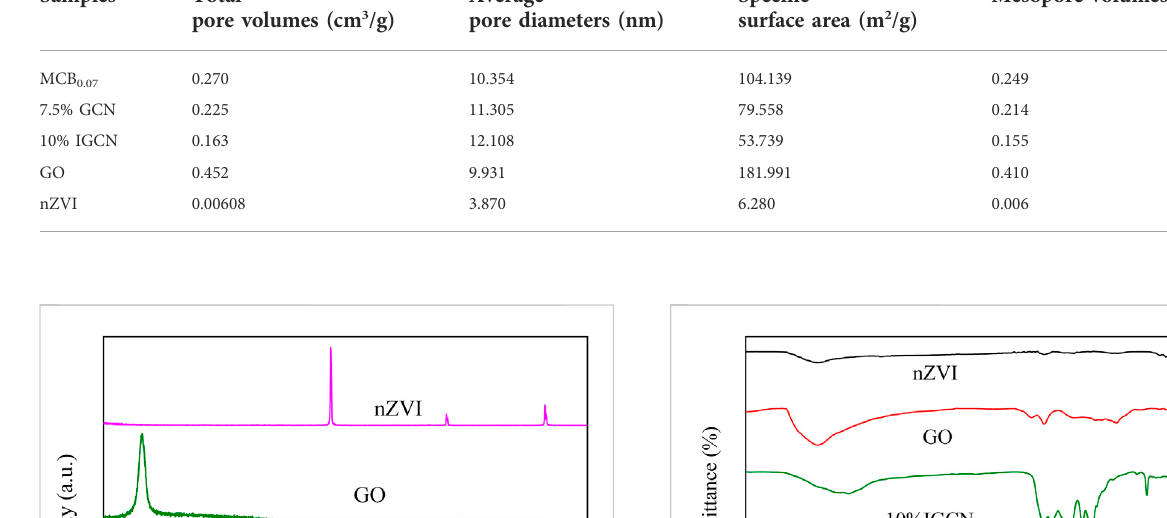
TABLE 1 The speci fi c surface area and pore structure of synthesized samples. Samples